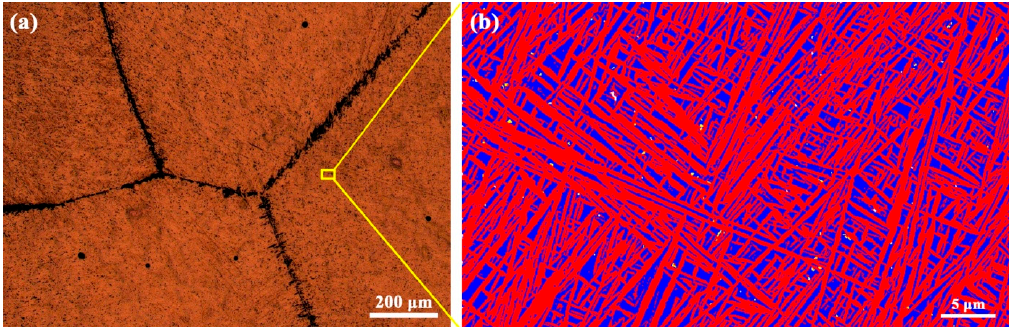
Figure 1. ( a ) OM (optical microscopic image) image of the present alloy heat-treated in β phase field followed by QC (brine-quenched). ( b ) Phase map shows the α 2 ′ martensitic laths in the β grain interior. The blue color denotes the β matrix and the red represents the α 2 ′ laths. The stepping size is 50 nm.